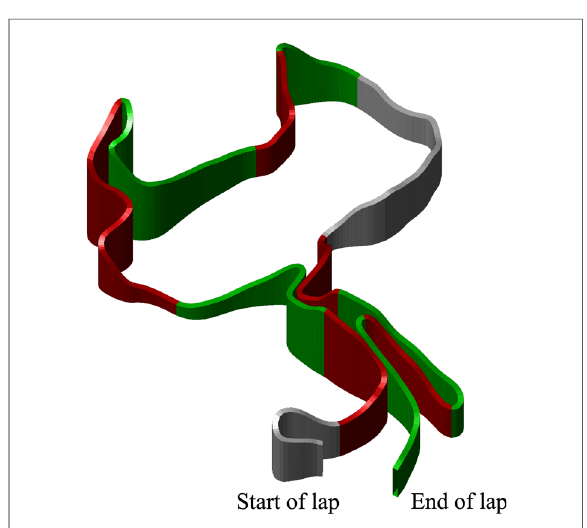
FIGURE 2 Three-dimensional visualisation of the racecourse used on Laps 2 – 6 in a 21.8 km cross-country skiing mass-start competition. The uphill segments are displayed in red, fl at segments in grey, and downhill segments in